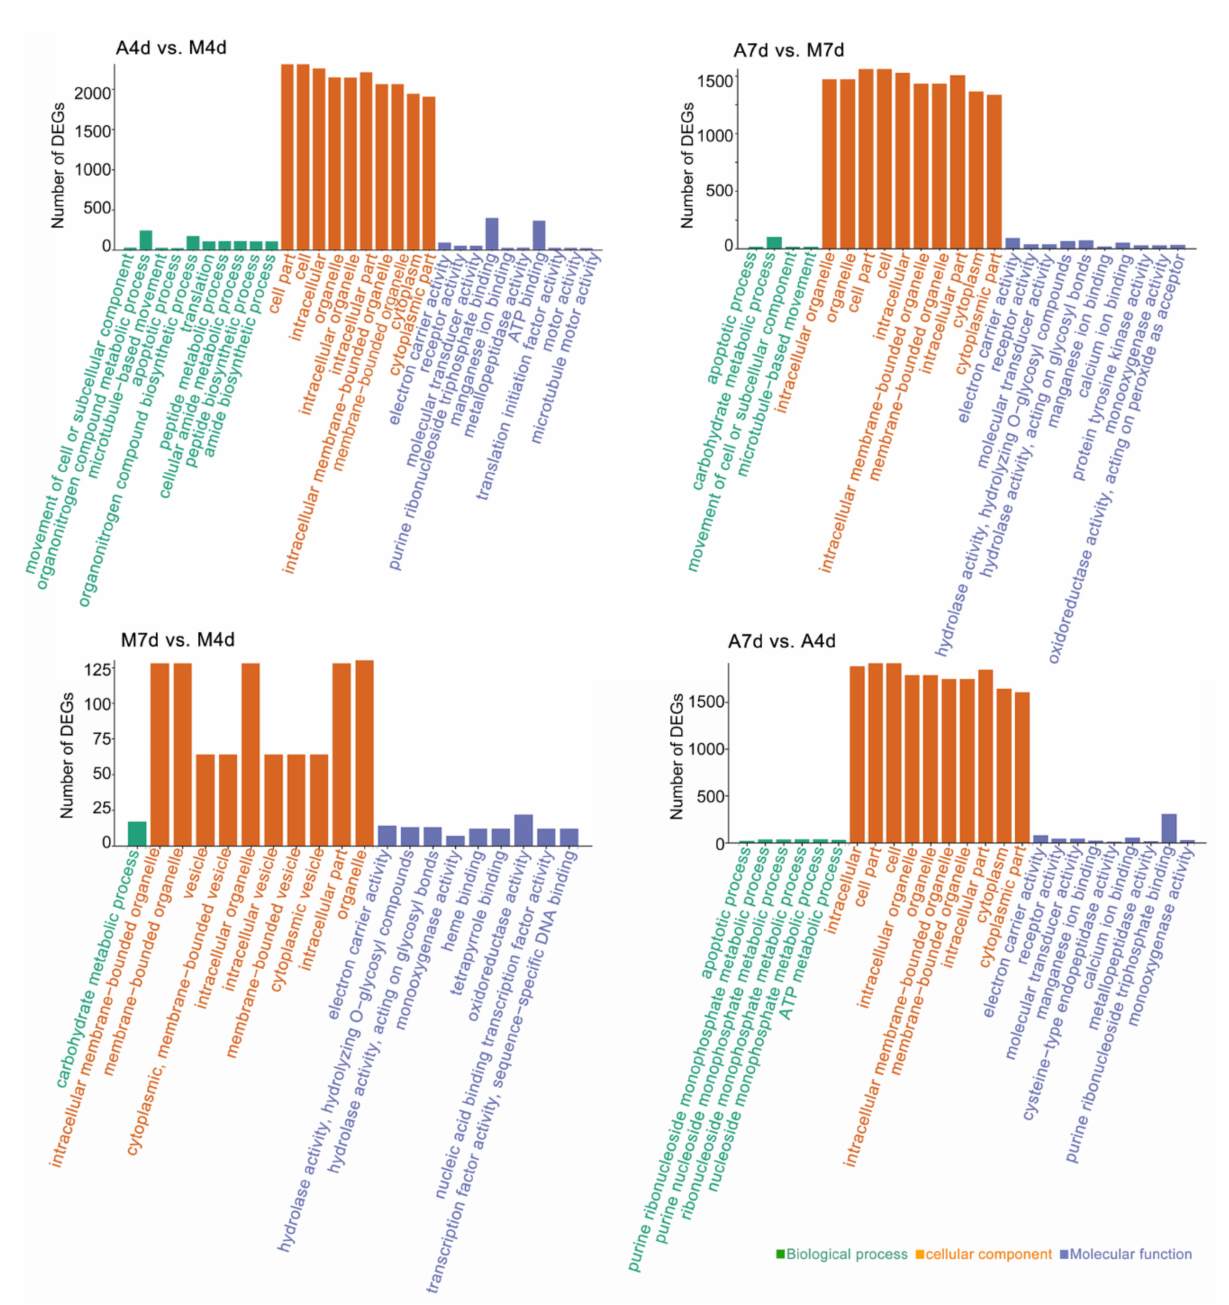
Figure 4. Gene Ontology (GO) enrichment analyses of DEGs were unique in A4d vs. M4d, A7d vs. M7d, M7d vs. M4d and A7d vs. A4d,